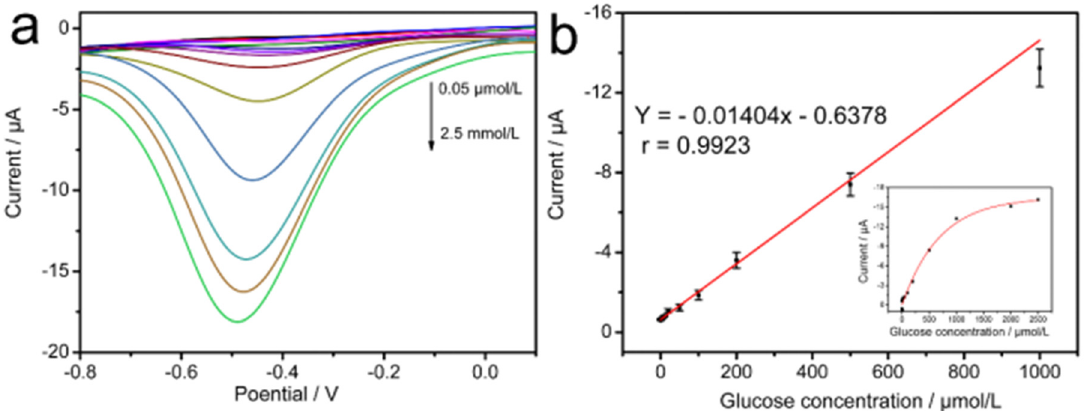
Figure 7. ( a ) SWVs of PQT@GCCA electrode in 0.2 mol/L NaClO 4 at different glucose concentration (0.05 µ mol/L–2.5 mmol/L). ( b ) The relationship between glucose concentration and reduction current; inset shows the linear relationship between glucose concentration and reduction current between 0.05 µ mol/L–1.0 mmol/L.